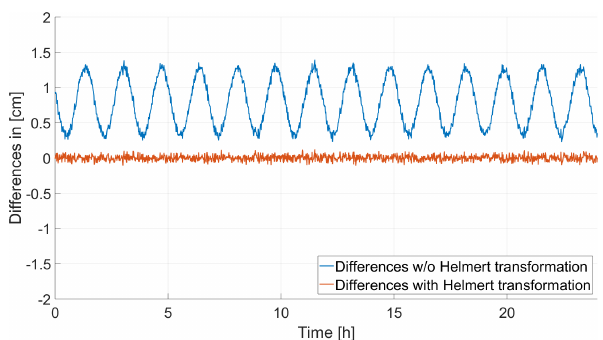
Figure 11. Along-track differences between combined solutions (reference EUM and DLR) for 24 September